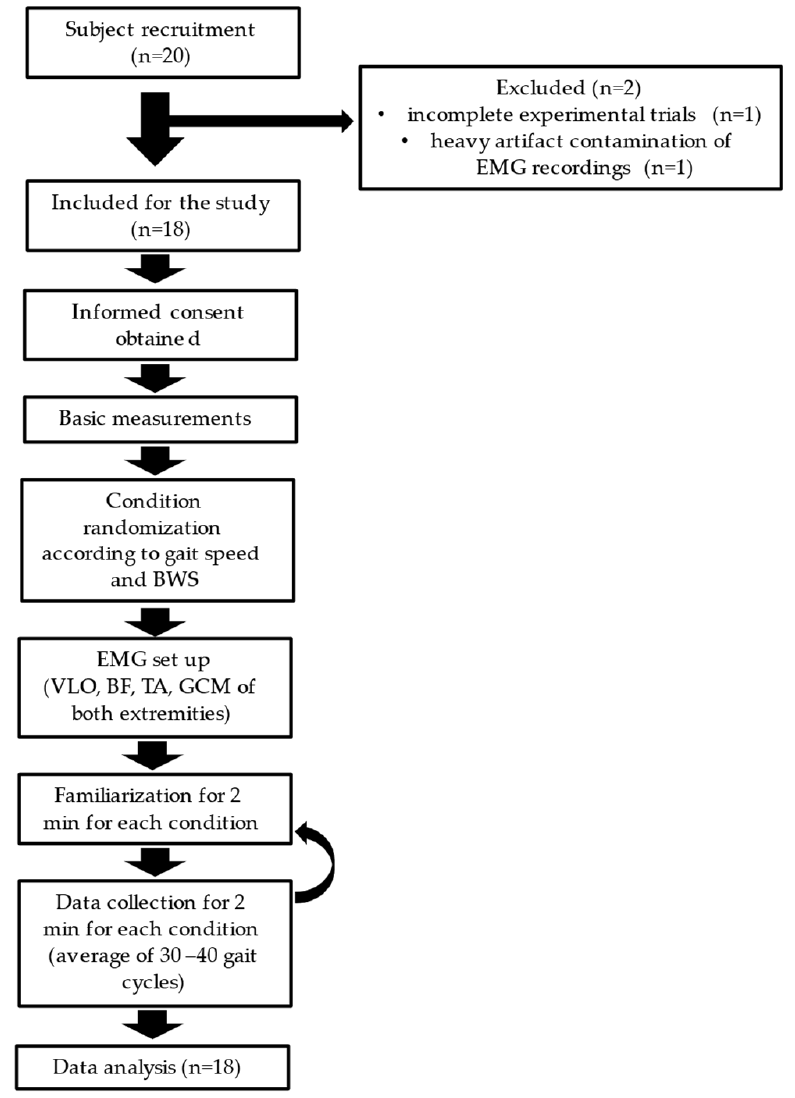
Figure 3. Flow chart showing the experimental design of the study.